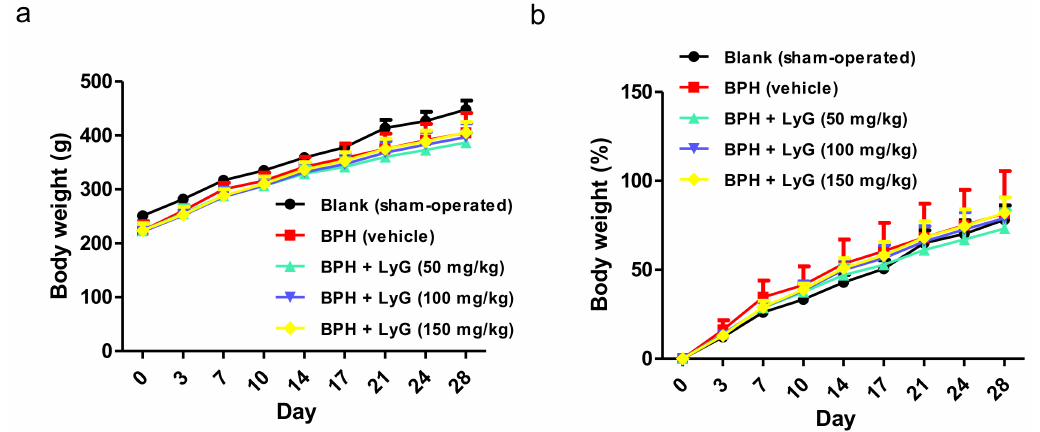
Figure 3. Body weight of BPH-induced rats who had an oral administration of Lycogen™ (LyG). ( a ) The mean body weight of each group and ( b ) the mean body weight normalized to the control of each group that were exhibited for BPH-induced rats during the period of Lycogen™ administration. The data were presented as mean ± SD. Blank: sham-operated; BPH: BPH-induced rats; BPH +